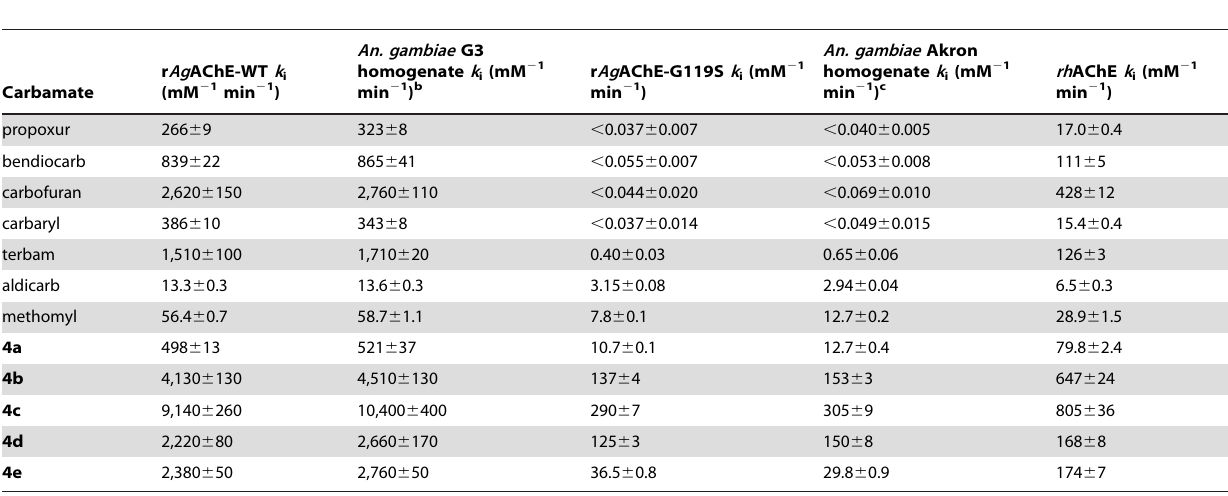
Table 2. Carbamate inactivation rate constants k i for r Ag AChE (WT & G119S), An. gambiae homogenates (G3 & Akron), and r h AChE.